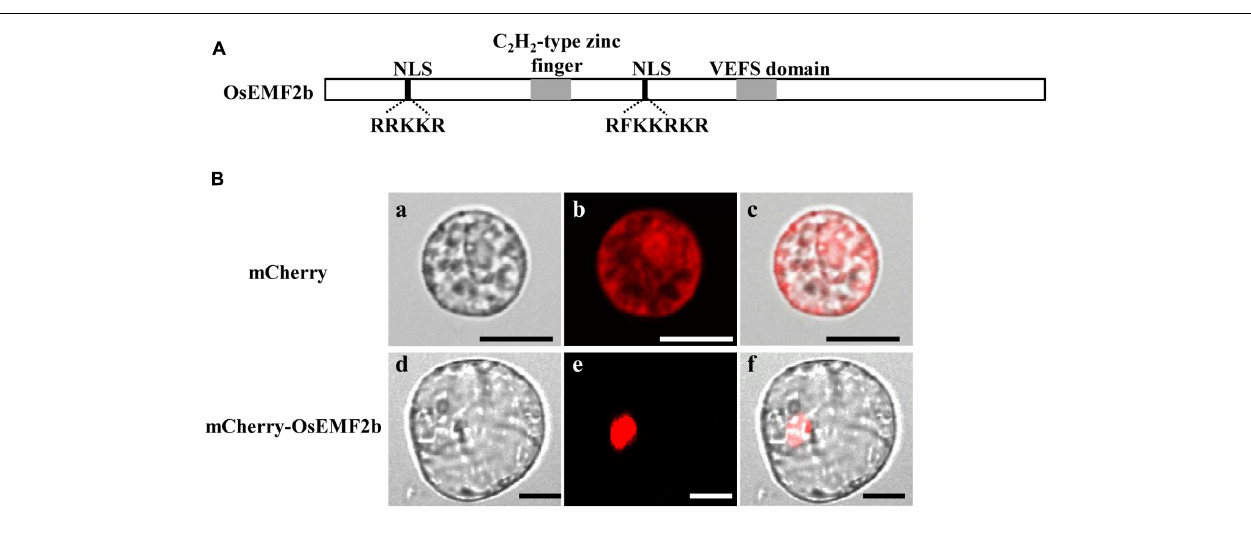
FIGURE 5 | Structure and nuclear localization of OsEMF2b. Schematic representation of OsEMF2b. The black boxes indicate two putative nuclear localization signals (NLS) with a basic segment (Lys-Lys-Arg-Lys-Arg), and the gray boxes indicate a C 2 H 2 -type zinc finger motif and the VRN2-EMF2-FIS2-SUZ12 (VEFS) domain, respectively. (A) Nuclear localization of OsEMF2b in rice protoplasts. (B) (a–c) Images of mCherry. (d–f) Images of mCherry-OsEMF2b fusion. (a,d) Bright-field images. (b,e) Red fluorescence images. (c,f) Merged images of (a,b,d,e) , respectively. Bars = 2 µ m in (a–c) , 4 µ m in (d–f)